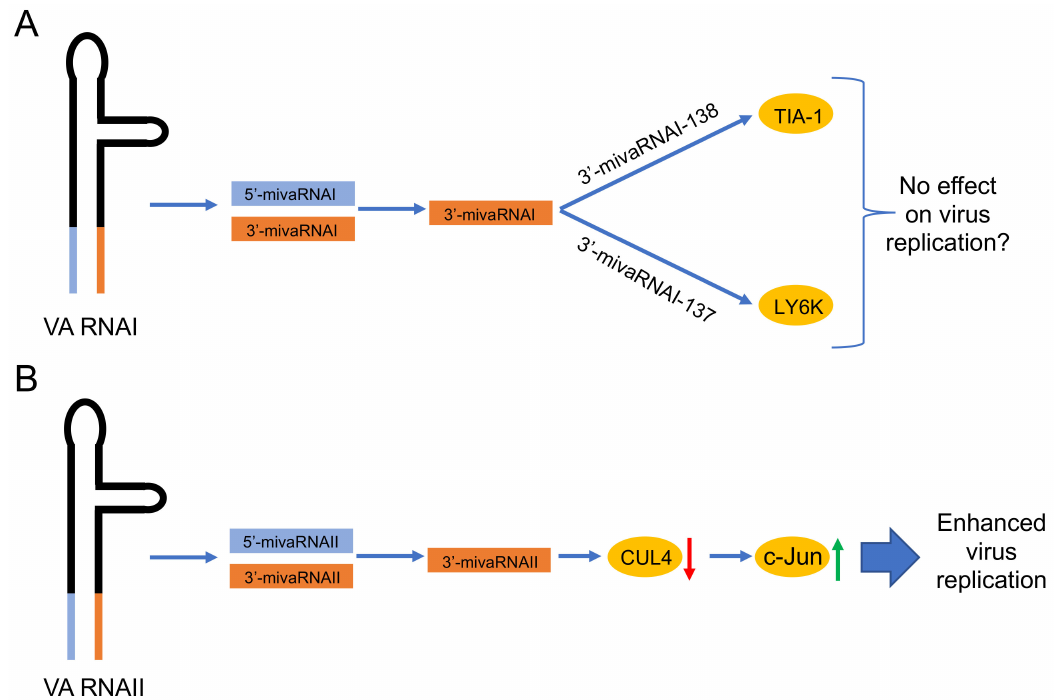
Figure 3. Proposed functions of the HAdV-5 mivaRNAs. ( A ) Validated targets (indicated in the yellow circles) of the mature 3’-mivaRNAI [19,21]. Since mutations in the 5’-mivaRNAI and 3’-mivaRNA sequences do not a ff ect virus growth [86,89], the possibility that these mivaRNAs do not have an e ff ect on virus growth is mentioned. ( B ) Proposed function of the 3’-mivaRNAII, which reduces CUL4 expression [94]. Low levels of the CUL4 protein will stabilize the c-Jun protein, which in turn enhances HAdV-5 growth. Red arrow, downregulation; green arrow,